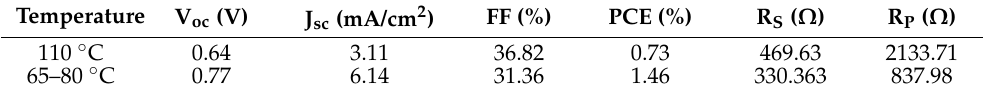
Table 4. Comparison of solar cell parameters of flexible devices annealed at different temperatures.